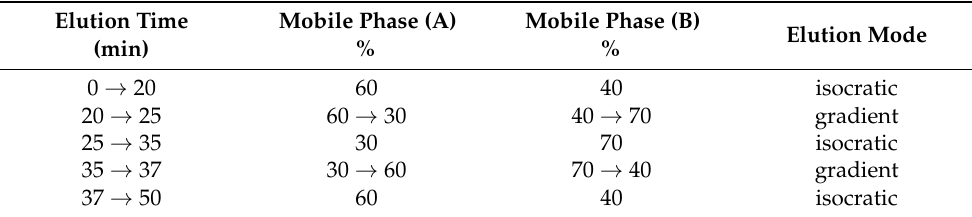
Table 2. Elution program adopted for the analysis of dansylated amine